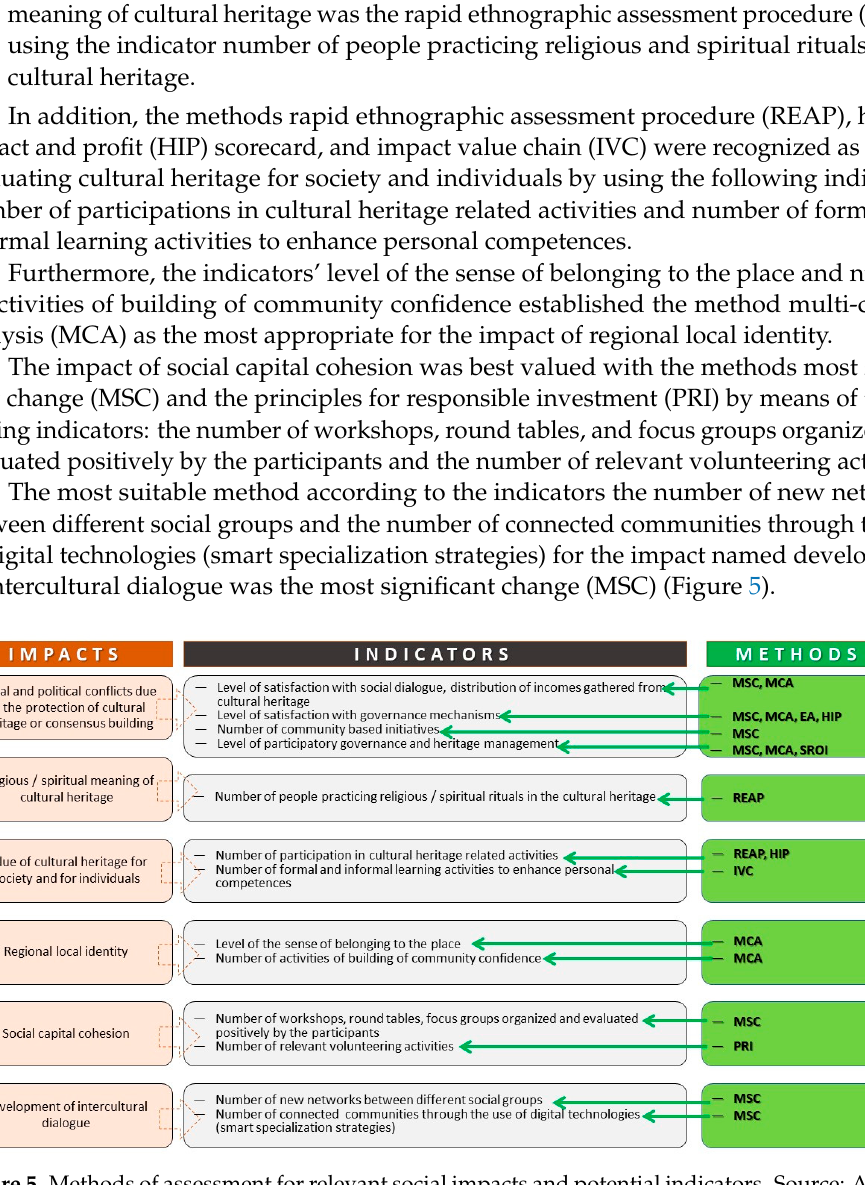
Figure 5. Methods of assessment for relevant social impacts and potential indicators. Source: Authors.